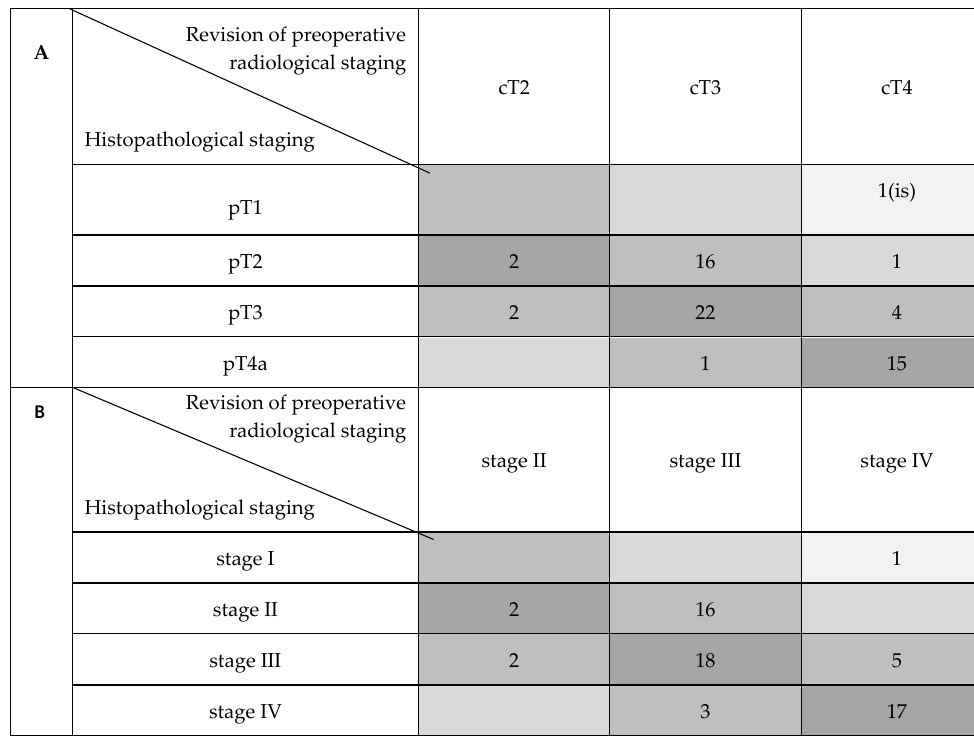
Figure 1. Compared distribution of cT with pT and cTNM with pTNM stages (AJCC 2017). ( A ) Comparison of cT and pT distribution. ( B ) Comparison of cTNM and pTNM stage distribution. In three of six radiologically over-staged cases (50%), a history of previous radiotherapy was described; the two radiologically down-staged cases were the result of false negative neck lymph nodes on CT